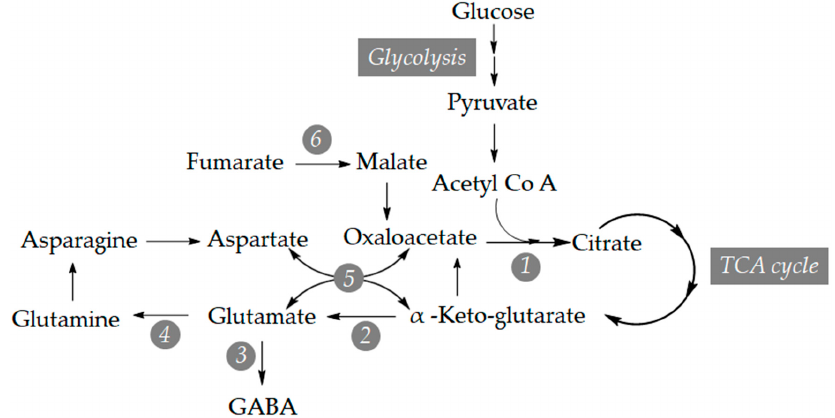
Figure 3. The metabolic inter-relationship between plant metabolism of malate, aspartate, GABA and glucose. 1 : Citrate synthase (mCS), 2 : Glutamate dehydrogenase (GDH), 3 : Glutamate decarboxylase (GAD), 4 : Glutamine synthetase (GS), 5 : Aspartate aminotransferase (AST), 6 : Fumarase (FH).